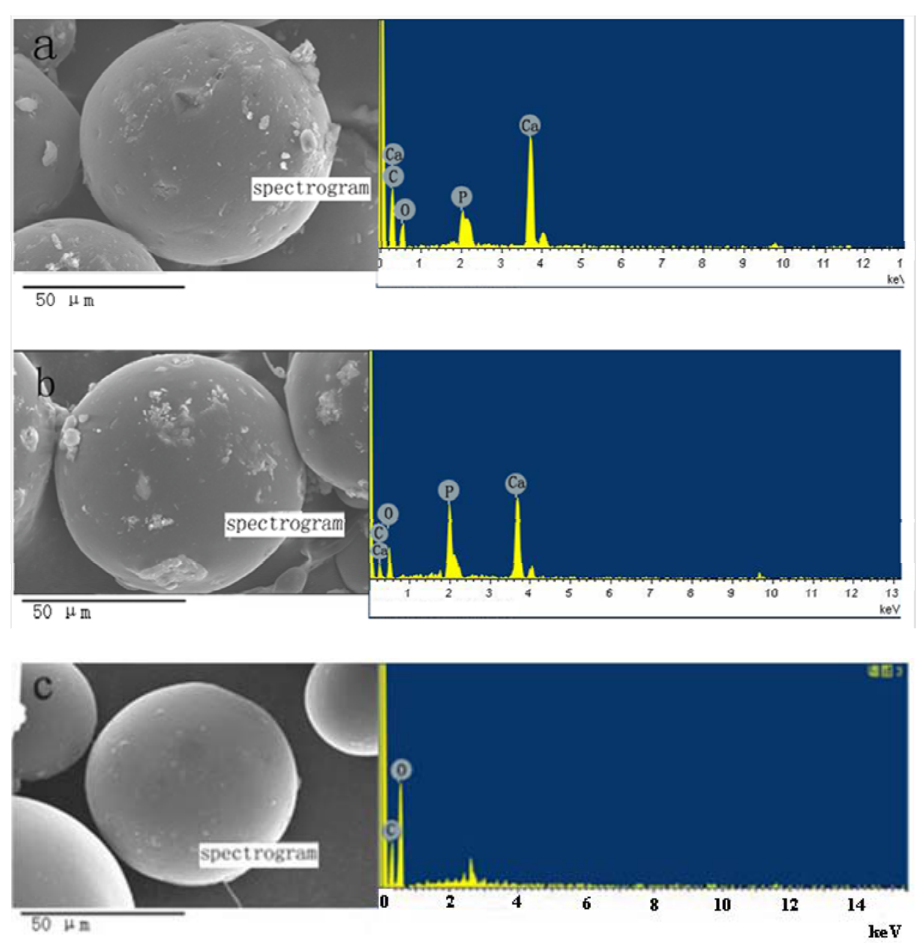
Figure 2. The morphology of the TMZ/PLGA/nHA and TMZ/PLGA microspheres and the energy disperse spectroscopy (EDS) patterns of wrinkling. ( a )